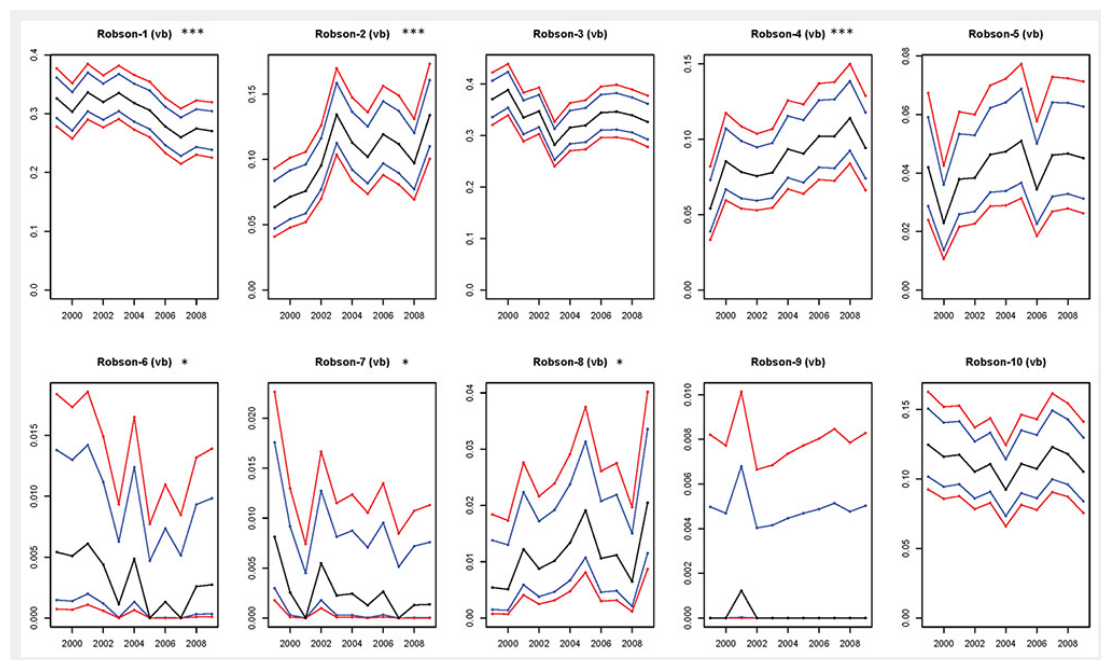
Figure 4 Temporal change within each Robson group in births delivered vaginally. Relative size is presented in the observed period of time. Blue lines are 95% confidence limits and red lines are simultaneous 95% confidence limits. The relative sizes of Groups 1, 6 and 7 decreased significantly and the relative sizes of Groups 2, 4 and 8 increased significantly. *p ≤0.05, **p ≤0.01, ***p